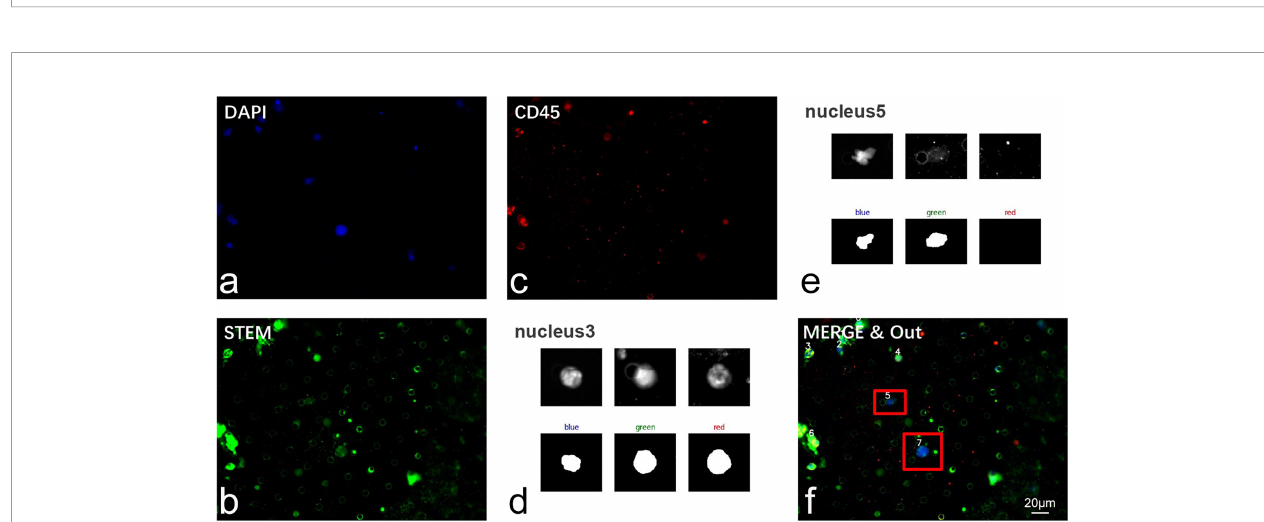
FIGURE 5 | Validation of CTC recognition algorithm in clinical samples. (A – C) Representative IF image of cells isolated from glioma patients ’ peripheral blood. Cells were sequentially labeled by DAPI (blue), STEAM (green), and CD45 (red). (D, E) Automatic segmentation of nucleated cells. (F) Automatic recognition of CTC through our algorithm. CTCs were marked by red anchor box. Scale bar = 20 m m.